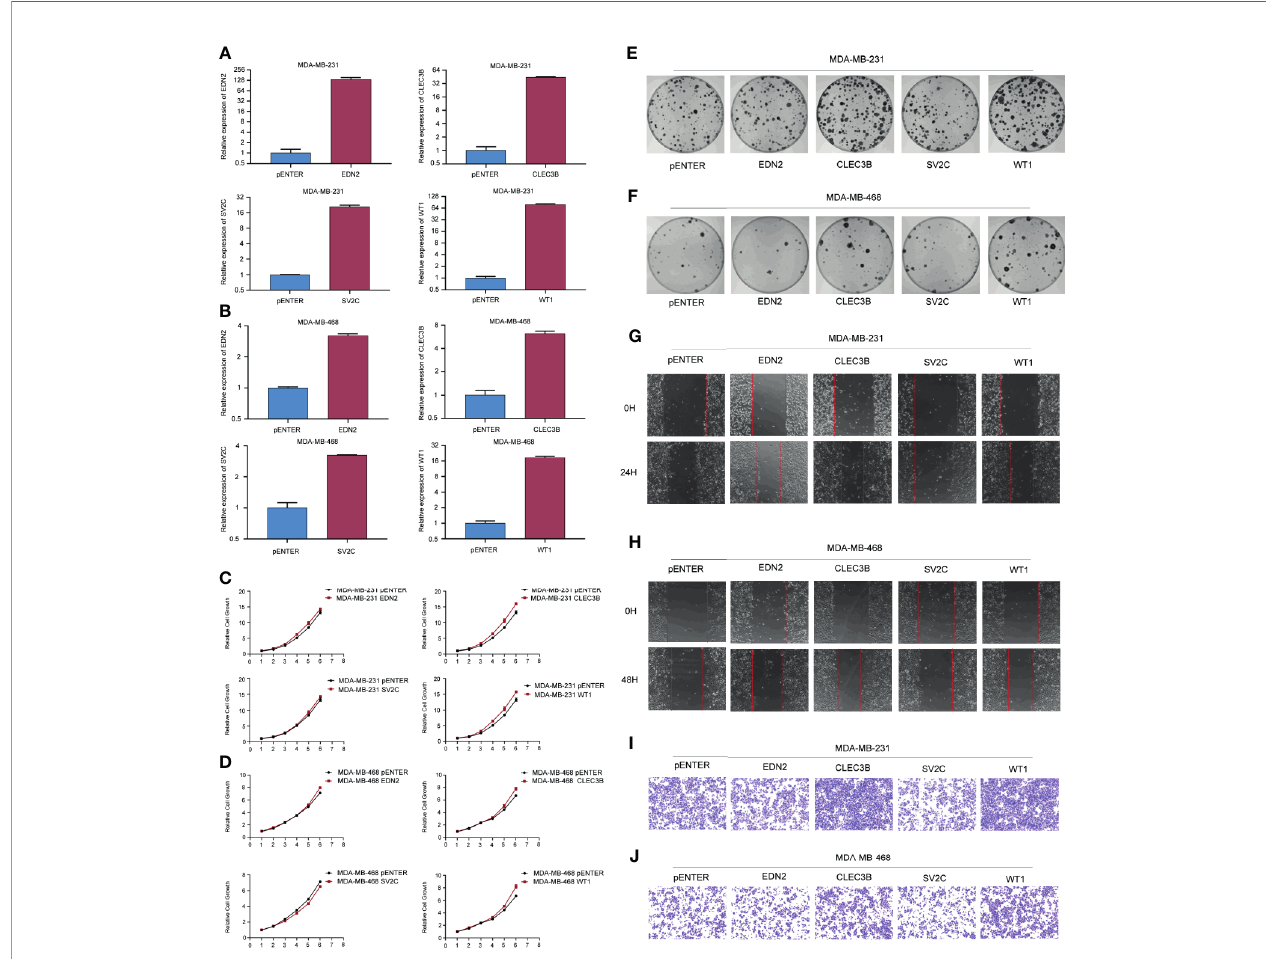
FIGURE 9 | Gain-of-function assay of selected genes regulating cell proliferation and metastasis. (A, B) The overexpression ef fi ciency of the selected genes in MDA- MB-231 and MDA-MB-468 cells. (C, D) Effect of the selected genes on cell proliferation was tested by MTT in MDA-MB-231 and MDA-MB-468 cells. (E, F) Effect of the selected genes on cell proliferation was tested by colony formation assay in MDA-MB-231 and MDA-MB-468 cells. (G, H) Effect of the selected genes on cell migration was tested by scratch assay in MDA-MB-231 and MDA-MB-468 cells. (I, J) Effect of the selected genes on cell migration was tested by transwell assay in MDA-MB-231 and MDA-MB-468